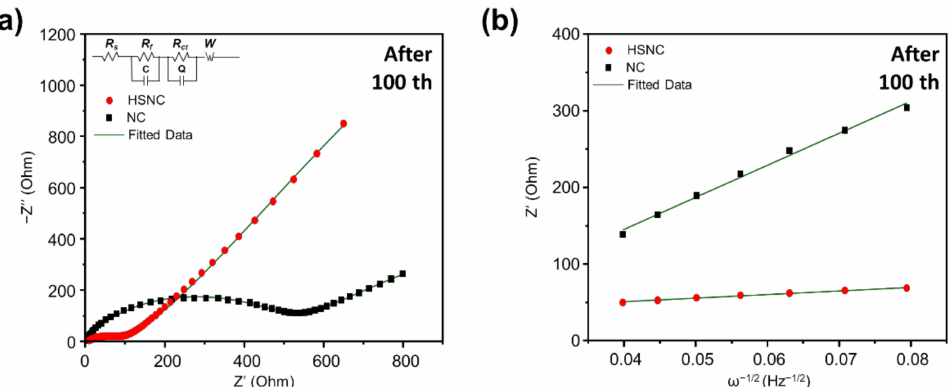
Figure 7. ( a ) Nyquist plots and ( b ) relationships between Z’real and ω − 1/2 at a low-frequency region of the HSNC and NC samples after 100 cycles at a current density of 0.2 A · g − 1 and a voltage range of 0.01–3.0